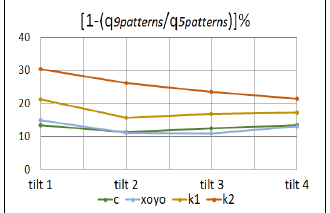
Figure 9. The effect of using 9 coplanar chessboards versus 5, presented as the proportional improvement of cofactor values